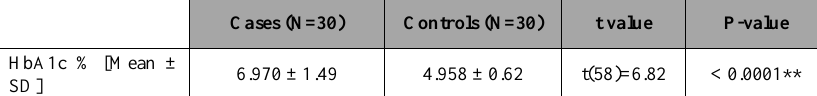
Table 6. Comparison of HbA1c level between case and control groups.